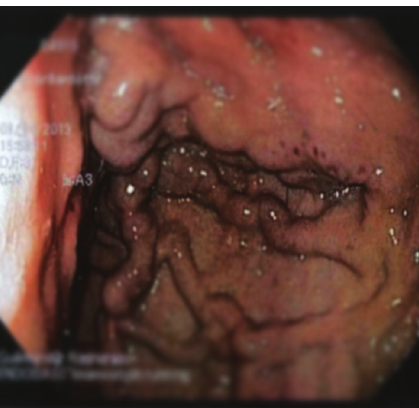
Figure 1: Upper gastrointestinal endoscopy. Isolated gastric varices in the fundus of the stomach and red spots in the mucosa of the varices.